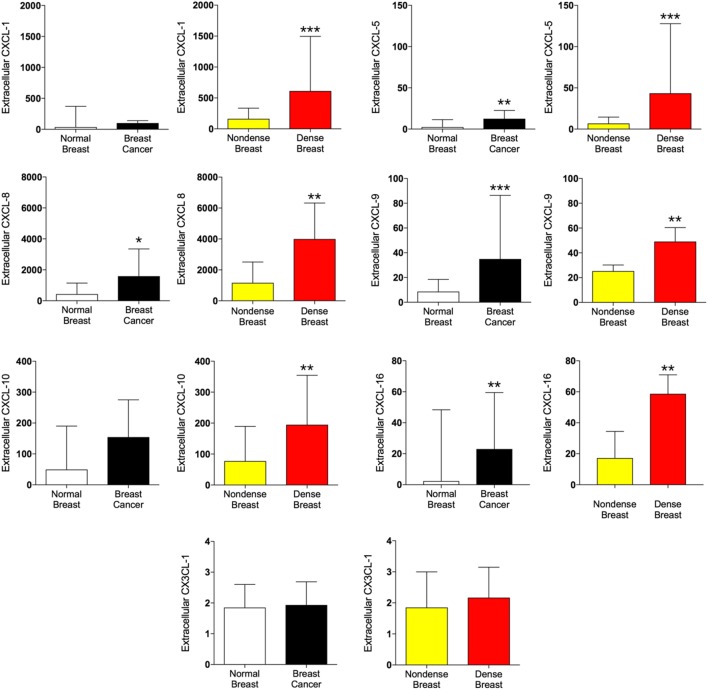
Extracellular levels of CXCL, CX3CL1, and IL-18 in vivo in breast cancers and healthy normal breast tissue with different densities. 51 women were investigated using microdialysis; 12 breast cancer patients underwent microdialysis before surgery. One catheter was inserted into the breast cancer (black bars) and another into adjacent normal breast tissue (white bars). 39 postmenopausal healthy volunteer women, attending the regular mammography-screening program and were categorized as either having dense or non-dense breasts underwent microdialysis of their left breast. Women with dense breasts (n = 20) are depicted in red and women categorized as non-dense (n = 19) are depicted in yellow. Data represent protein abundance in linear values (2NPX as described in the Section “Materials and Methods”). Graphed data are presented as median with 95% CI (*P < 0.05, **P < 0.01, ***P < 0.001).